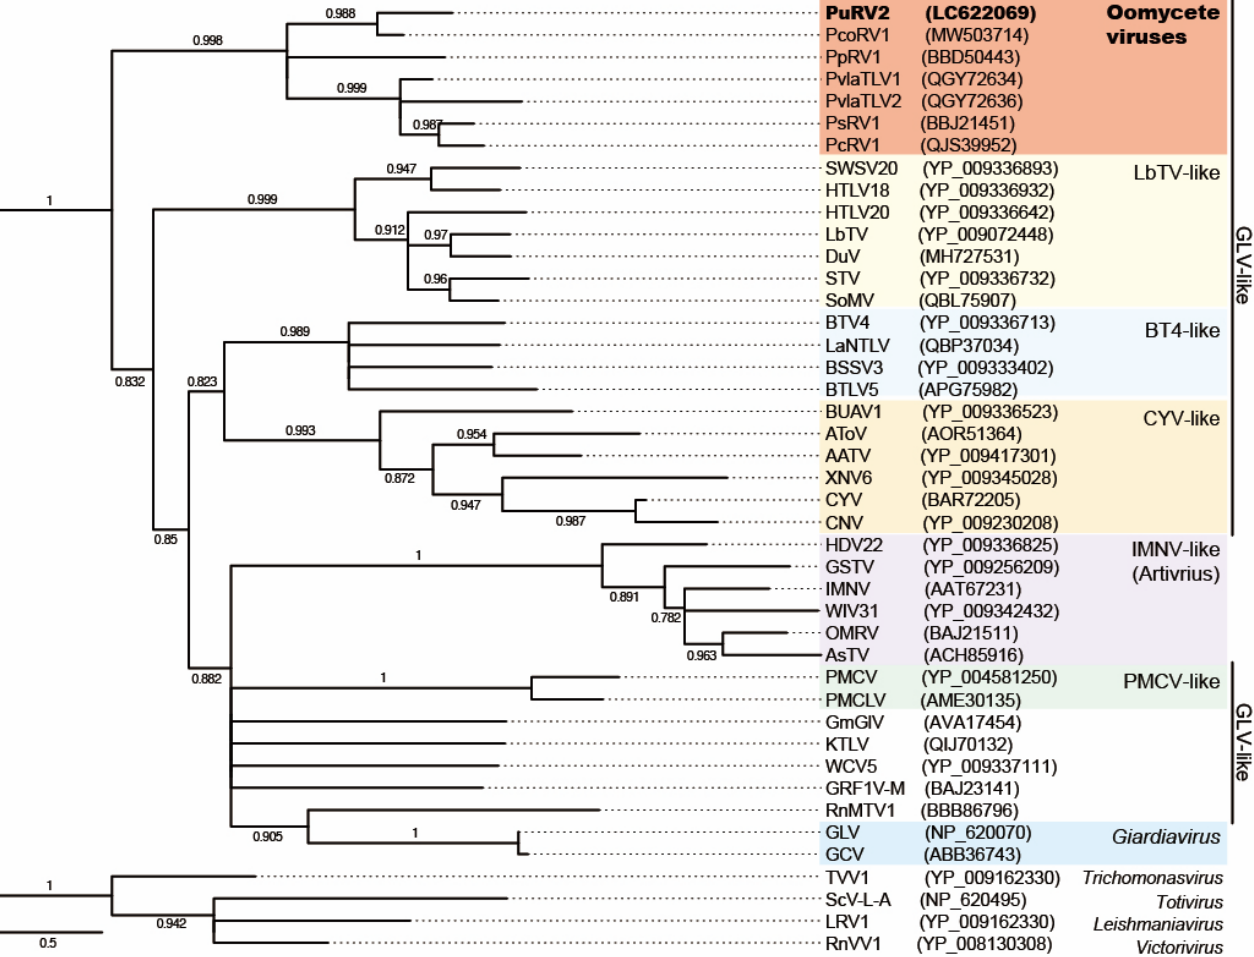
Figure 5. The maximum likelihood tree (LG + I + G + F) based on amino acids of the RdRp domain from viruses in the GLV-like and IMNV-like groups. RdRp of Totivirus (ScV-L-A), Victorivirus (RnVV1), Trichomonasvirus (TVV1), and Leishmaniavirus (LRV1) in the family Totiviridae were used for rooting. The numbers on branches indicate the results of SH-like approximate likelihood ratio tests (aLRTs). Branch support values larger than 0.6 are shown. Scale bar shows substitutions per site.